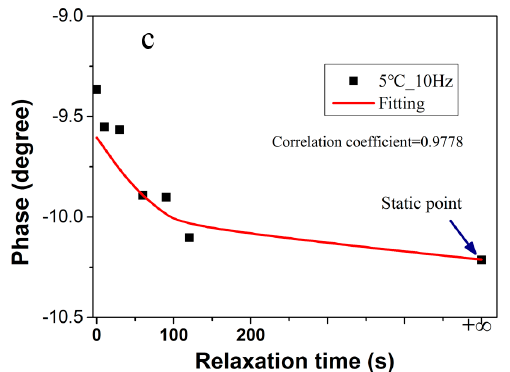
Figure 8. Experimental and fitting results of impedance phase shift at 10 Hz. Phase shift results at ( a ) 20 °C; ( b ) 10 °C; and ( c ) 5 °C.